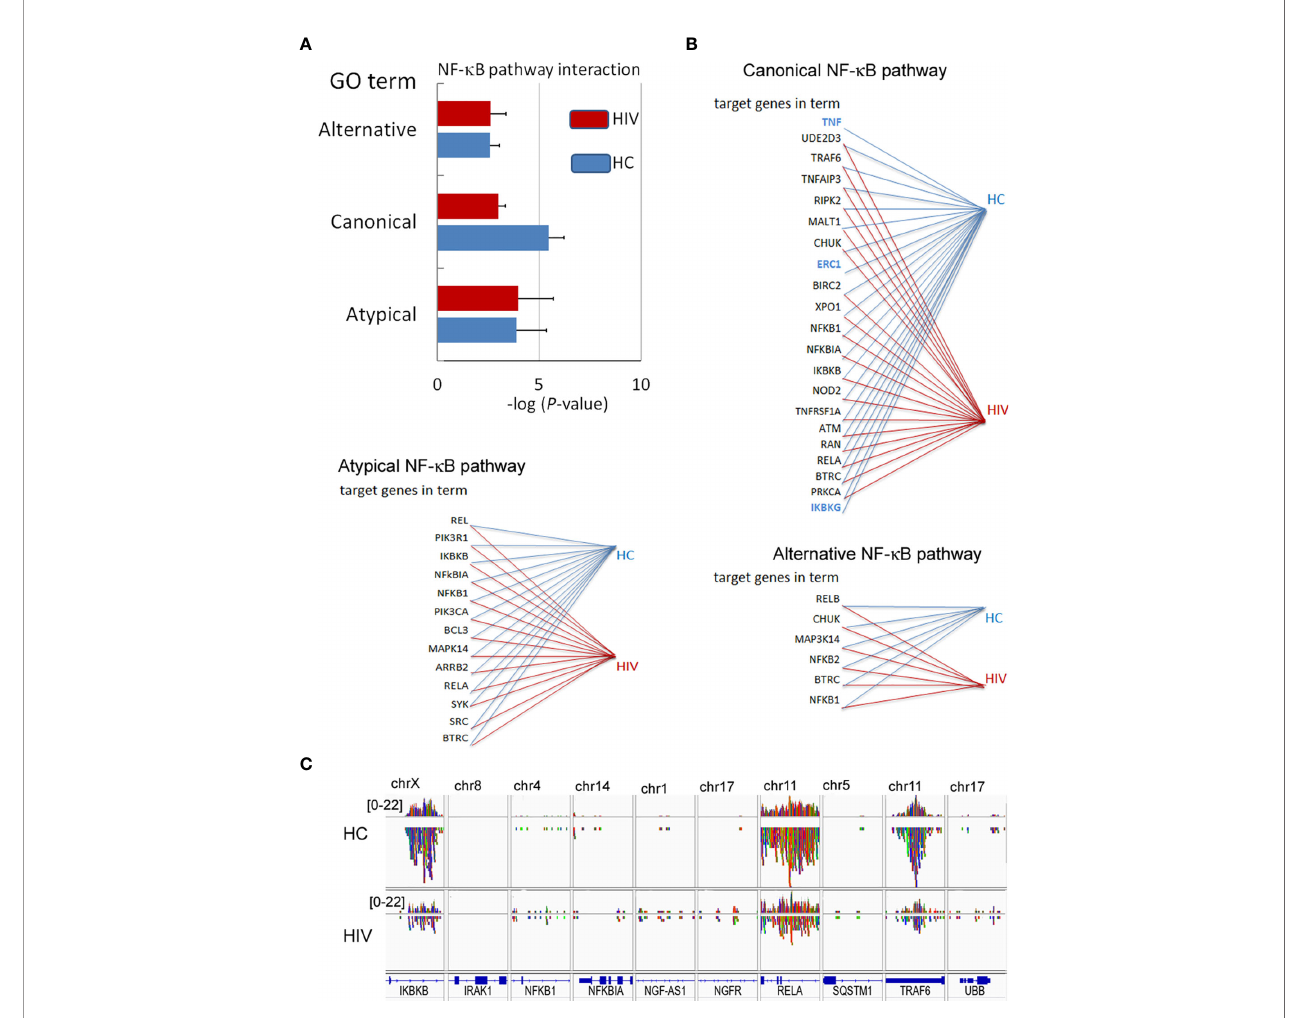
FIGURE 5 | Changes in the DNA within H3K4me3-marked histone affect canonical NF- k B pathways. (A) The analyses of GO terms: alternative, canonical, and atypical NF- k B pathways. The bars represent mean values for HCs (n=3) and HIV-infected individuals (n=3) (B) The analysis of target genes in the GO term ‘ Canonical NF- k B pathway ’ indicated the lack of signals for TNF , ERC1 , and IKBKG within H3K4me3 in HIV neutrophils (blue color). (C) The comparison of selected genes related to NF- k B shows a statistically signi fi cant smaller number of NGS readings (low density) within RelA , IKBKB , and TRAF6 coding genes related to the GO term ‘ Canonical NF- k B pathway ’